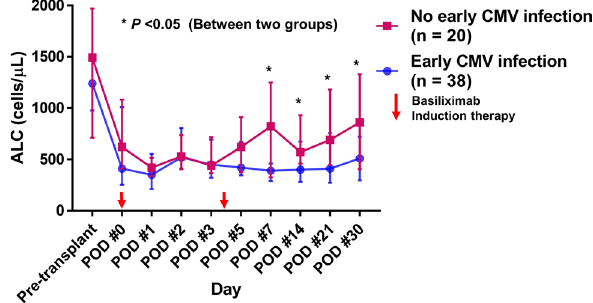
Figure 1. Time course of median value of ALC following heart transplantation. ALC = absolute lymphocyte count, CMV = cytomegalovirus, POD = postoperative day.